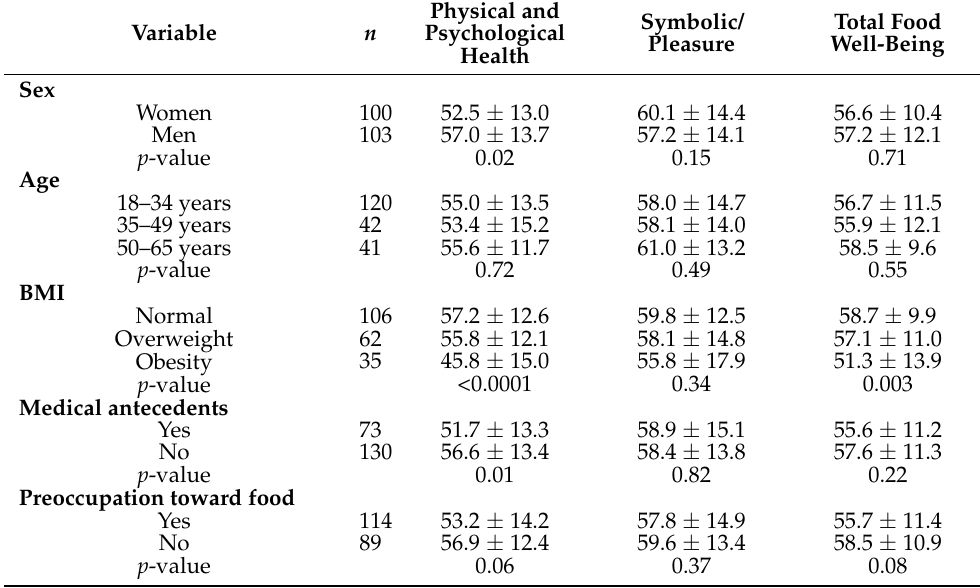
Table 5. Comparisons of food well-being scores according to sex, age, body mass index, medical antecedents, and preoccupation toward